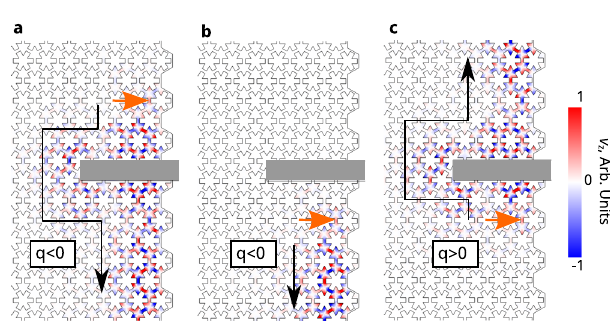
Fig. 3 | Unidirectional and backscattering-immune phonon transport through CESs.a , b CESsexcitedbyapointsourceattheinterfacebetweenaphononicChern insulator and air above and below the large scatterer (gray region), when the bulk has a negative doping charge density ( q <0). c The CES propagates along the opposite direction when the bulk doping charge density is positive ( q >0). The blue-red color scheme represents the out-of-plane velocity v z